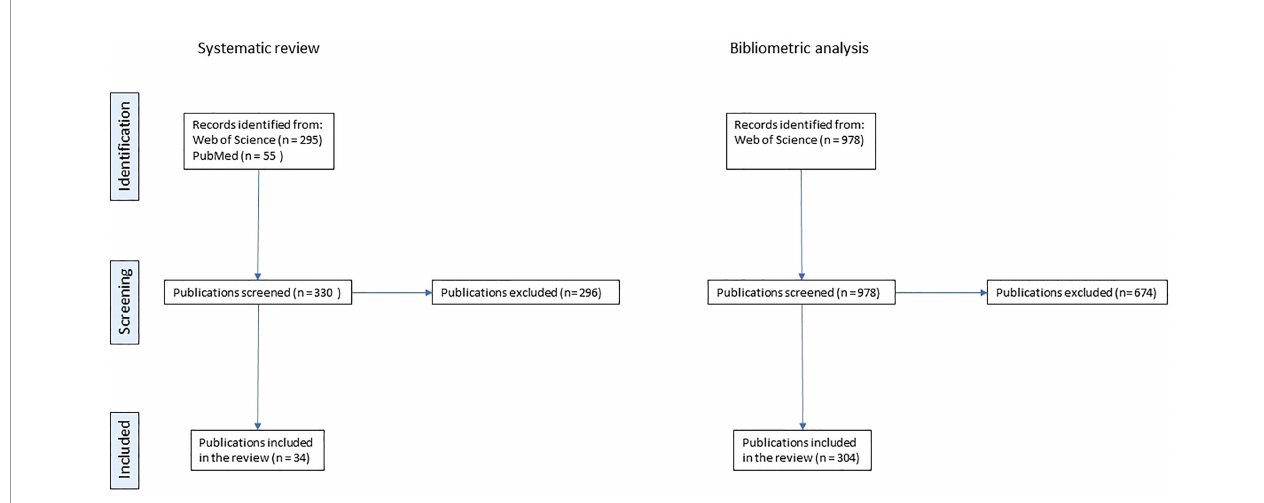
FIGURE 1 | PRISMA fl owchart describing the selection process for systematic reviews and for original papers included in the bibliometric